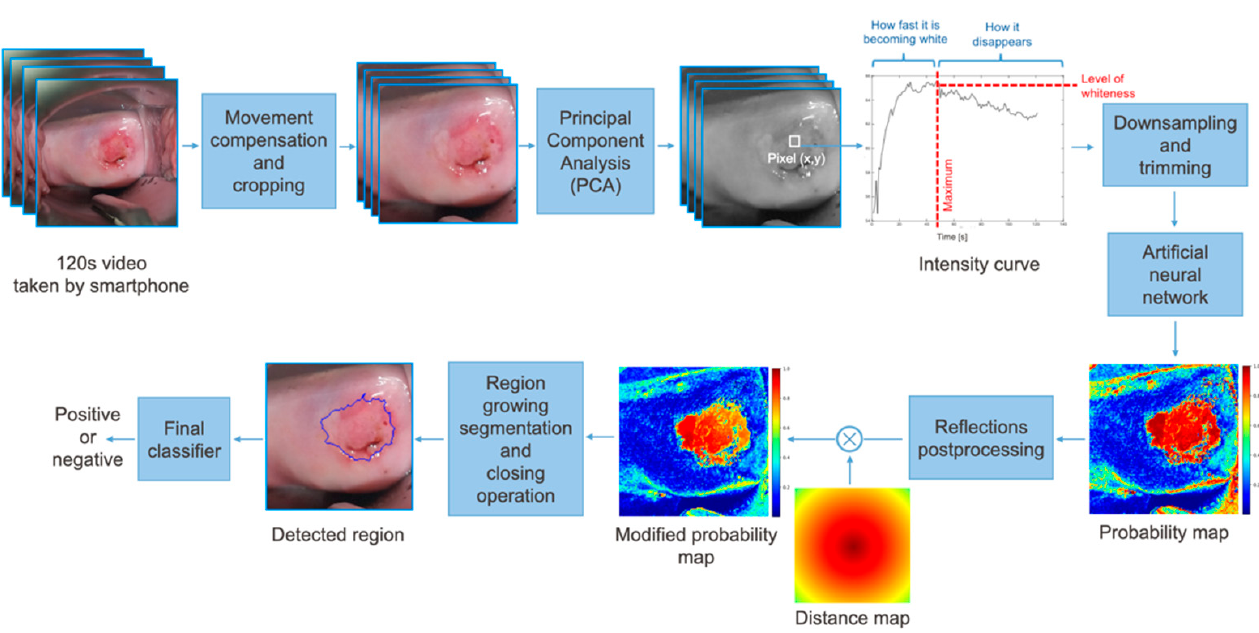
(c) Figure 1. For the supervised learning, positive and negative pixels are chosen from area far from ground truth contours, to avoid mislabeled training data due to inaccurate labeling. From left to right: ( a ) Label drawn by the colposcopist, validated by biopsy, ( b ) eroded label, where positive pixels are chosen from (green region), ( c ) dilated and masked label, where negative pixels are cho- sen from (green region). 2.2. Classifier